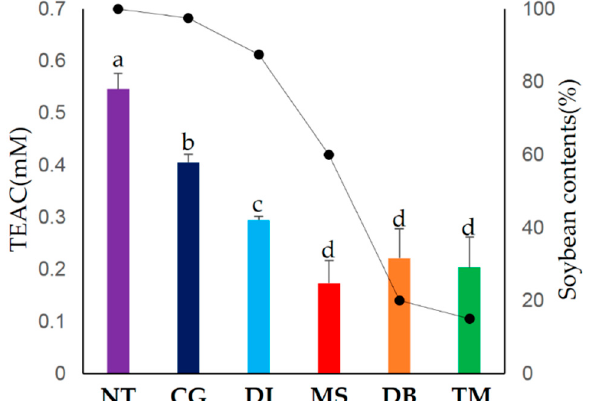
Figure 3. Comparison of ABTS (bar graph) and soybean content (line graph) for six FSPs. All the values were averaged for the six FSP types. Different letters in the table indicate the significant difference obtained by ANOVA followed by Duncan’s multiple-range test ( p -value < 0.05).